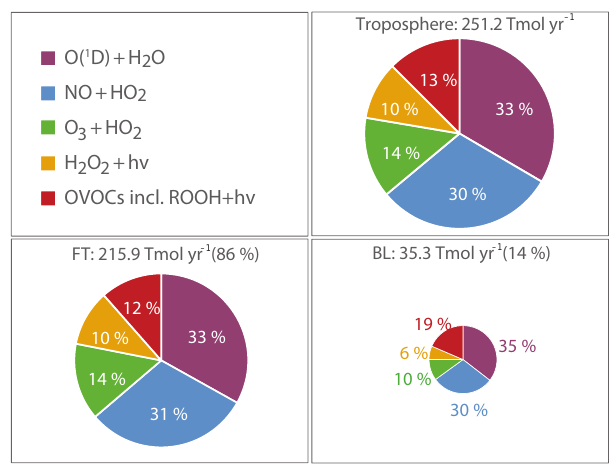
Figure 6. Main production terms of OH (Tmolyr − 1 ) in the tropo- sphere (top right), free troposphere (bottom left) and boundary layer (bottom right). The sizes of the lower two graphs are proportional to the upper right graph, reflecting the percentages of G in parenthe- ses. We distinguish P (purple) from S , the latter being made up of the NO x mechanism (blue), the O x mechanism (yellow and green) and the OVOC mechanism